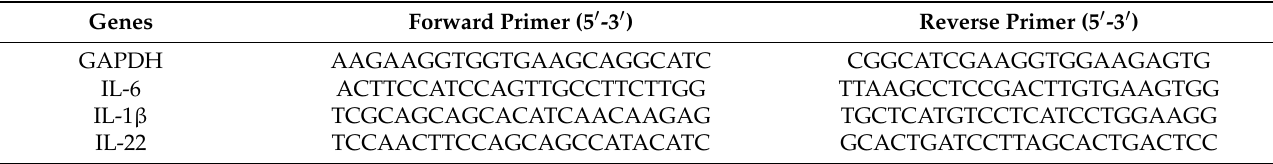
Table 1. Gene-specific primers used in RT–qPCR